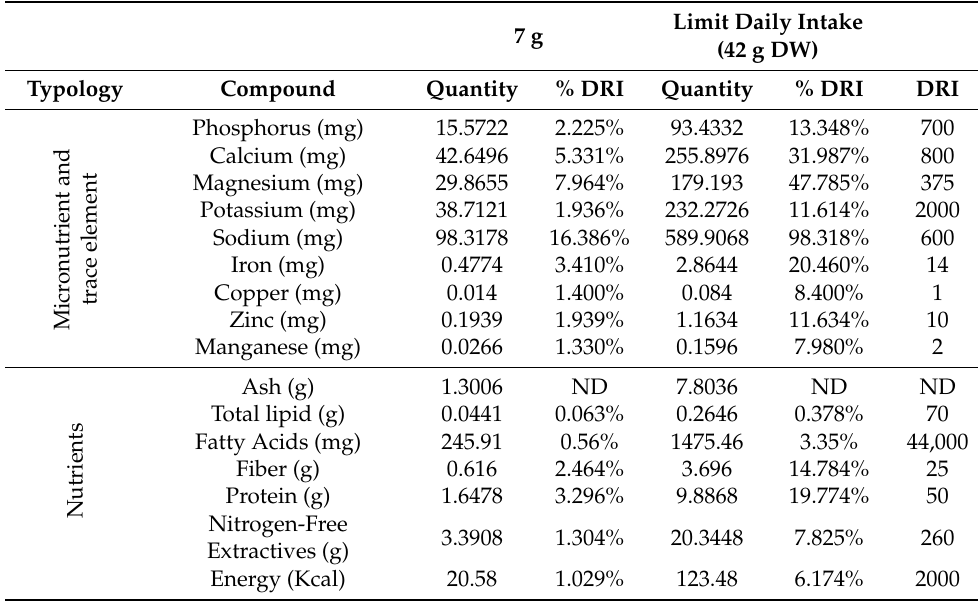
Table 10. Nutritional value in 7 g of U. pinnatifida according to the established Dietary Reference